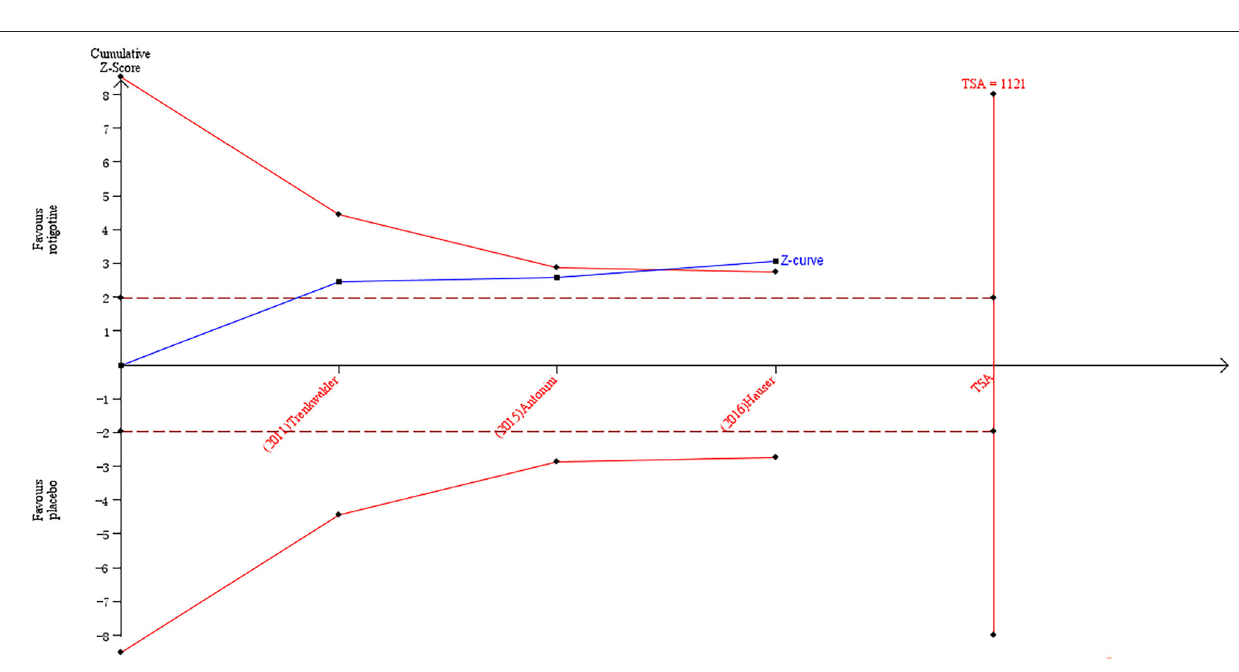
analysis, and the meta-analysis results showed that, compared after receiving the rotigotine treatment (two studies, n = 620,